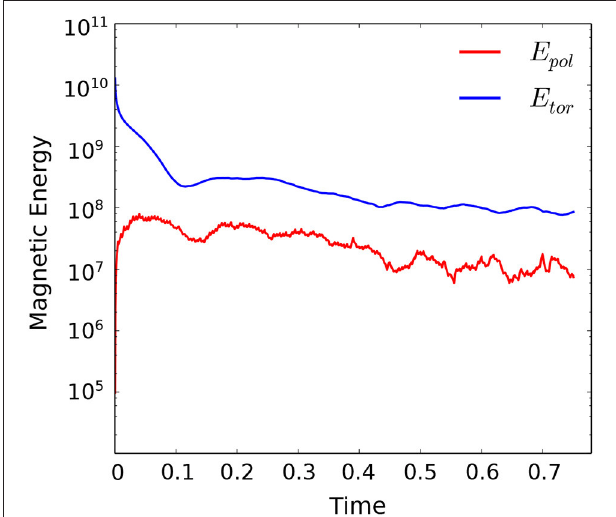
FIGURE 2 | The non-dimensional poloidal and toroidal magnetic energy with time (magnetic diffusion). Time t = 1 corresponds to one magnetic diffusion time (using the surface value for the magnetic diffusivity), which is approximately 77